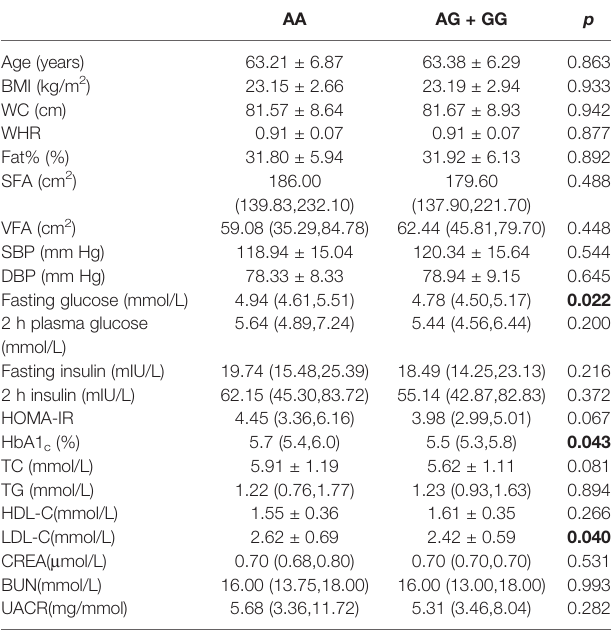
TABLE 3 | Associations of the IGF2 rs680 clinical traits in female samples. TABLE 4 | Best gene – gene interaction models of H19/IGF2/IGF2BP2/IGF2R